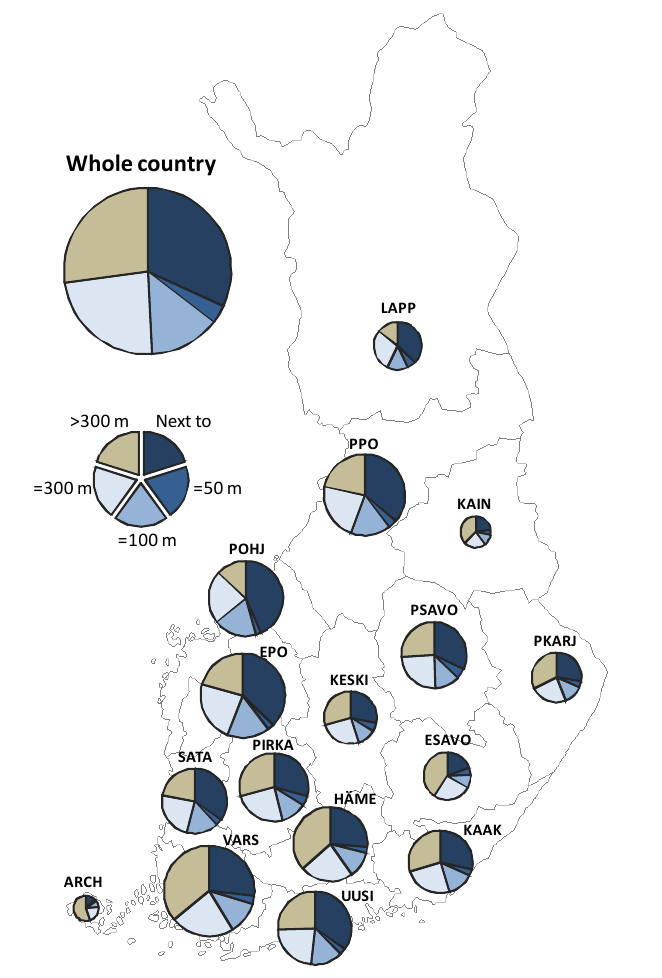
Fig. 1. Closeness of fields to waterways depending on region. The size of the circle indicates the total area (ha) of arable land in each region compared with Varsinais- Suomi as a reference (with the total of 296630 ha in 2011). Regions: UUSI, Uusimaa (1 in Fig. 4); VARS, Varsinais-Suomi (2); SATA, Satakunta (3); HÄME, Häme (4); PIRKA, Pirkanmaa (5); KAAK, Kaakkois-Suomi (6); ESAVO, Etelä-Savo (7); PSAVO, Pohjois-Savo (8); PKARJ, Pohjois-Karjala (9); KESKI, Keski-Suomi (10); EPO, Etelä- Pohjanmaa (11); POHJ, Pohjanmaa (12); PPO, Pohjois- Pohjanmaa (13); KAIN, Kainuu (14); LAPP, Lapplan (15); ARCH, Archipelago [Åland Islands (16)].